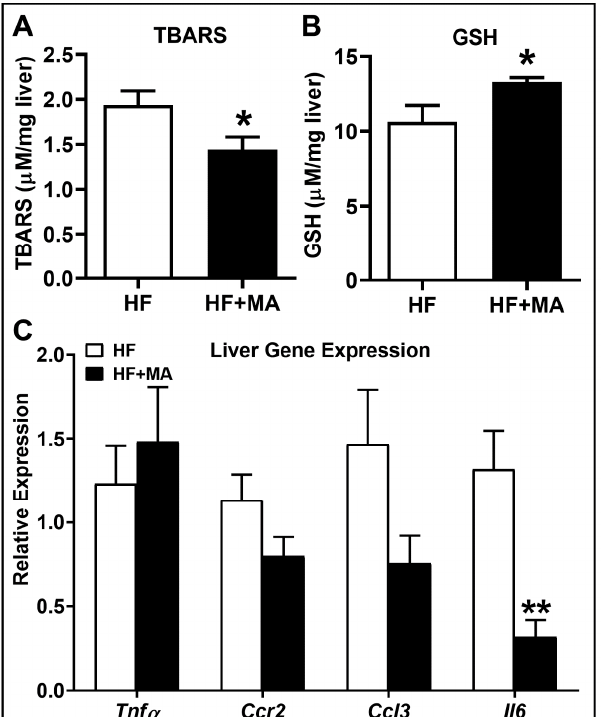
Figure 8. Effect of dietary myristic acid on hepatic oxidative stress and inflammation. The degree of lipid peroxidation was determined by measuring TBARS ( A ). Hepatic levels of total GSH were determined ( B ). Quantitative real-time PCR was performed in the liver for the mRNA levels of inflammatory genes ( C ). Values are expressed as mean ± SEM of 7–8 samples in each group. * p < 0.05 and ** p < 0.01 vs. HF. HF, high fat; HF+MA, high fat + myristic